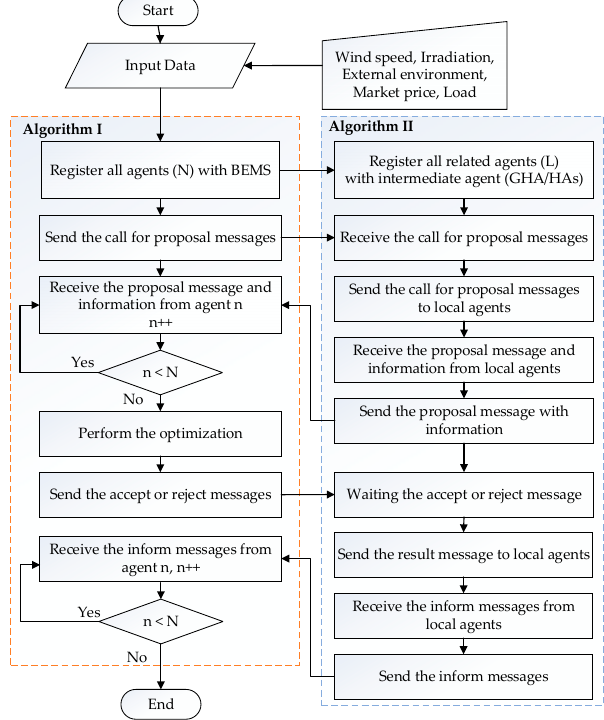
Figure 7. Flowchart for operation of the proposed building microgrid with rooftop greenhouse.